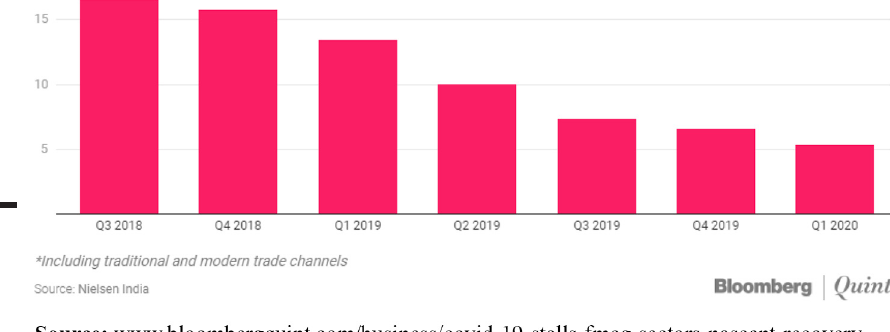
Figure 4. Year-on-year value growth of FMCG sector in